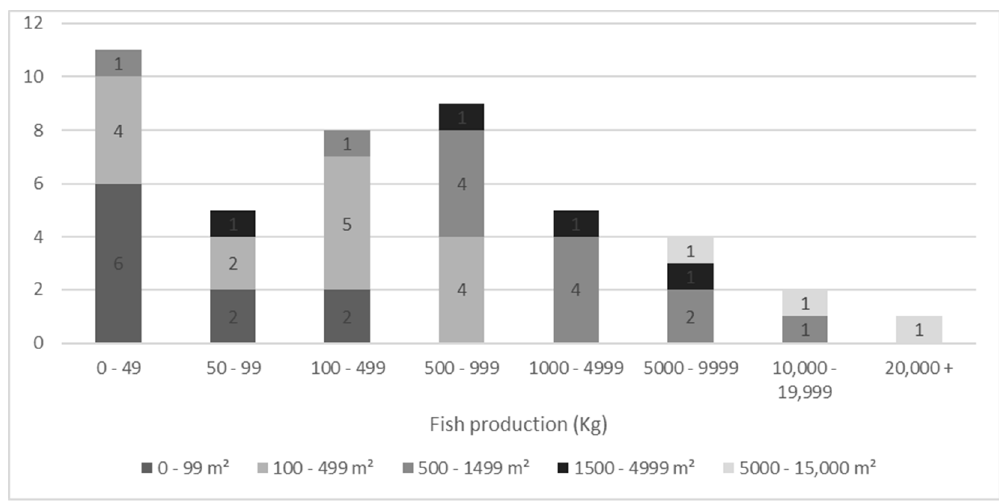
Figure 6. Fish yield and total surface of the aquaponic systems.